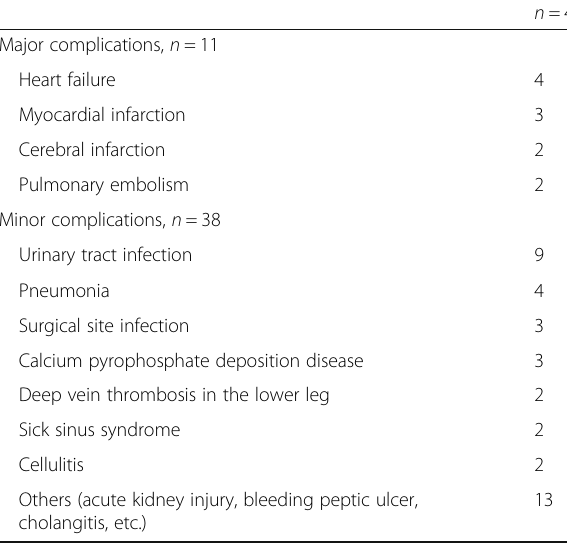
Table 2 Complications within 30 days after orthopedic surgery